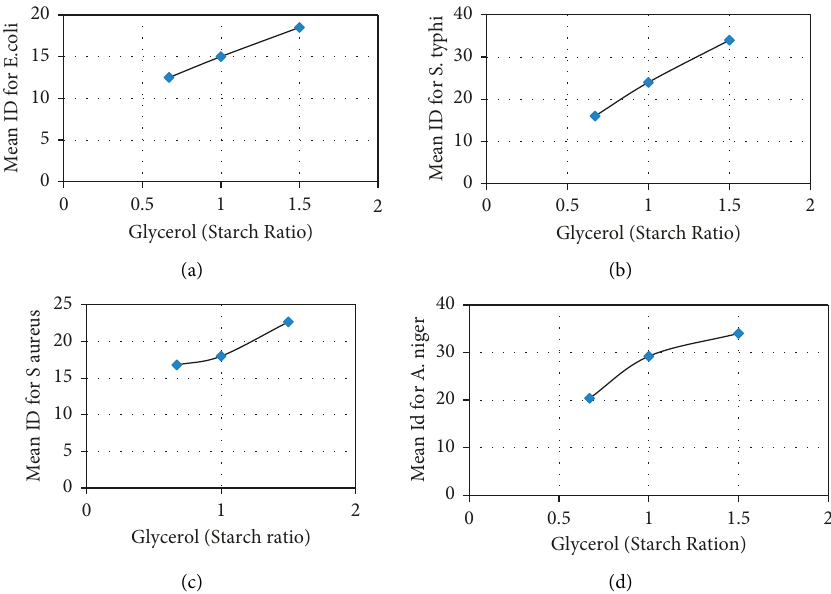
Figure 1: Effect of glycerol/starch ratio on inhibition diameter of (a) E . coli ; (b) S . typhi ; (c) S . aureus ; (d) A . niger .